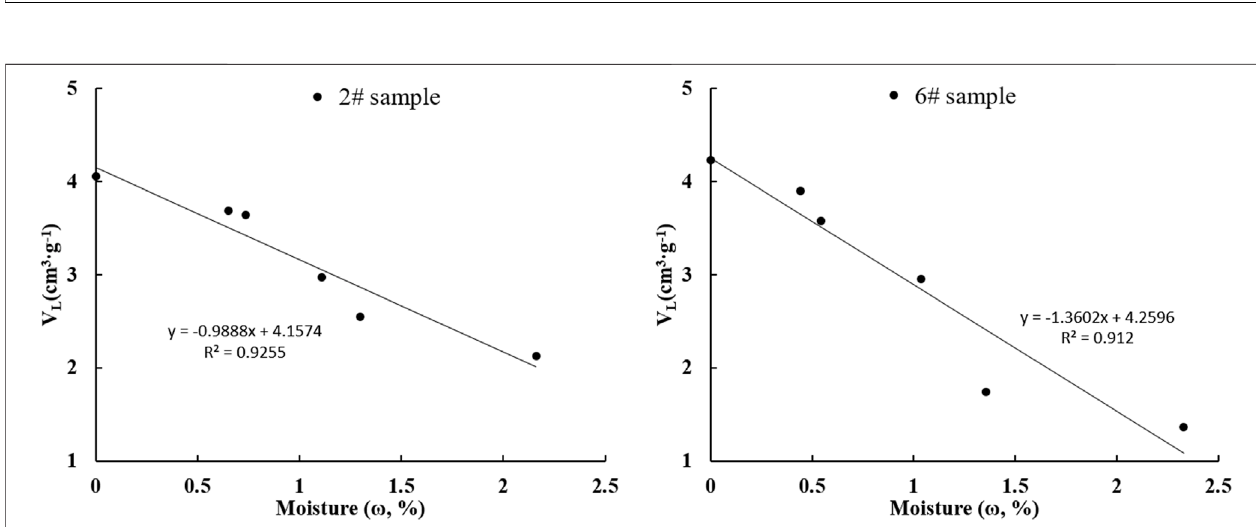
FIGURE 11 | Maximum adsorption capacity and moisture content of samples #2 and #6 (A. sample #2, B. sample #6).